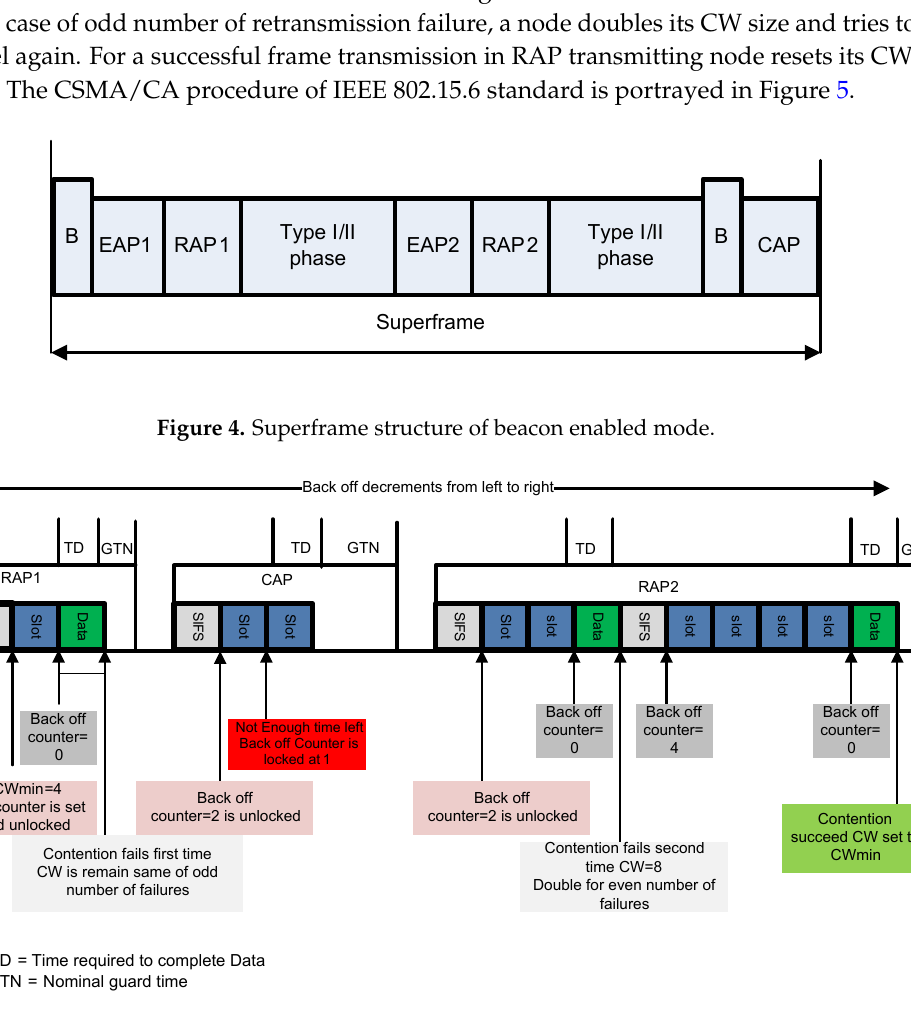
Figure 5. CSMA/CA procedure in IEEE